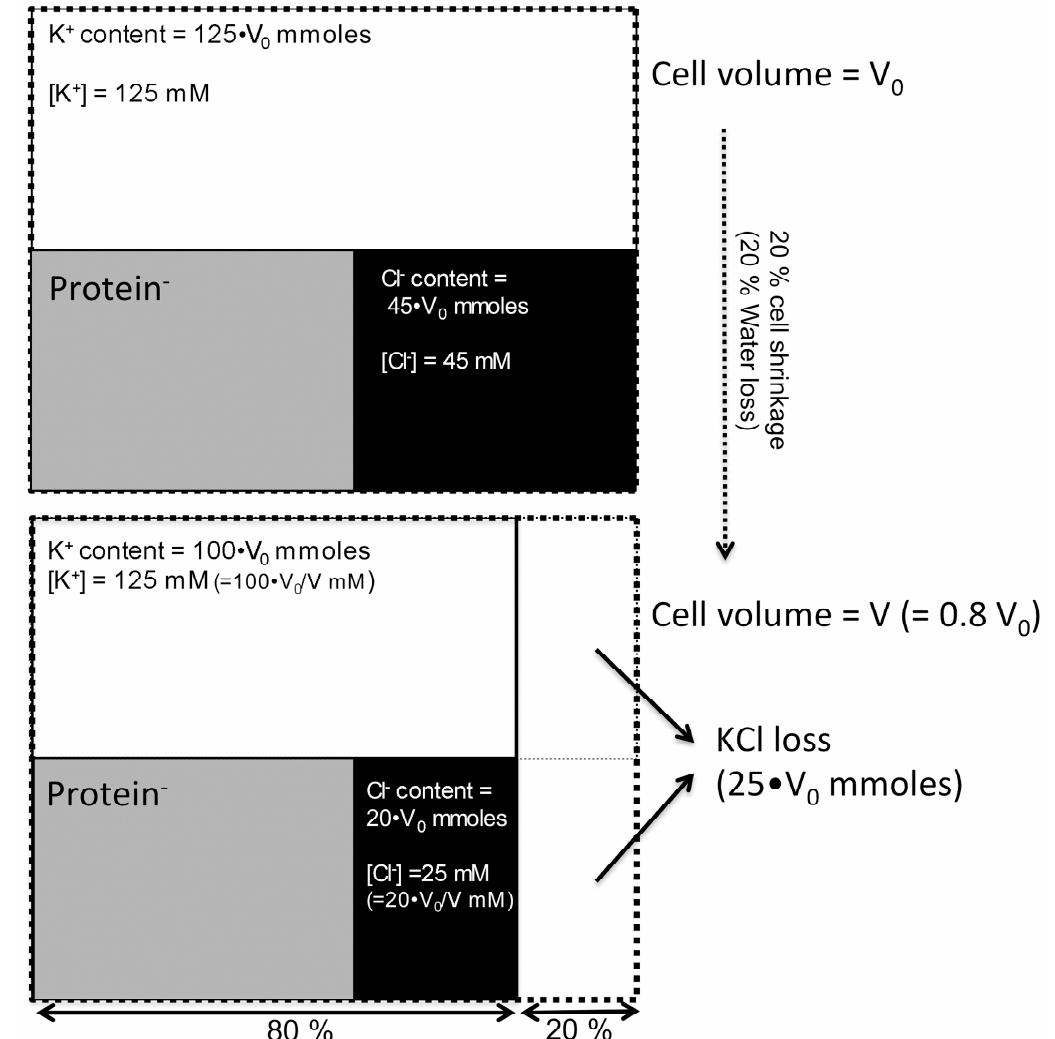
Figure 3. Decrease in [Cl − ] i induced by cell shrinkage under an isosmotic condition. In a model cell, [K + ] i and [Cl − ] i are 125 and 45 mM, respectively, in the unstimulated condition, while impermeable anions, such as proteins, maintain electroneutrality. Agonist stimulation activates K + or Cl − channels or both, leading to KCl release. Assuming an agonist decreases cell volume by 20% (KCl release decreases cell volume from V 0 to V (0.8 • V 0 ) under isosmotic conditions), the amount of KCl loss (mM) is 25 • V 0 . The KCl release from the cell does not alter [K + ] i , and it is maintained at 125 mM, but [Cl − ] i decreases to 25 mM.